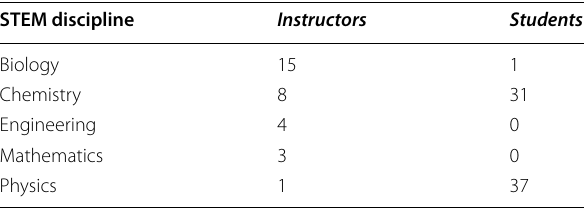
Table 1 Demographics of instructors (Faculty and TAs) ( n and students (n =